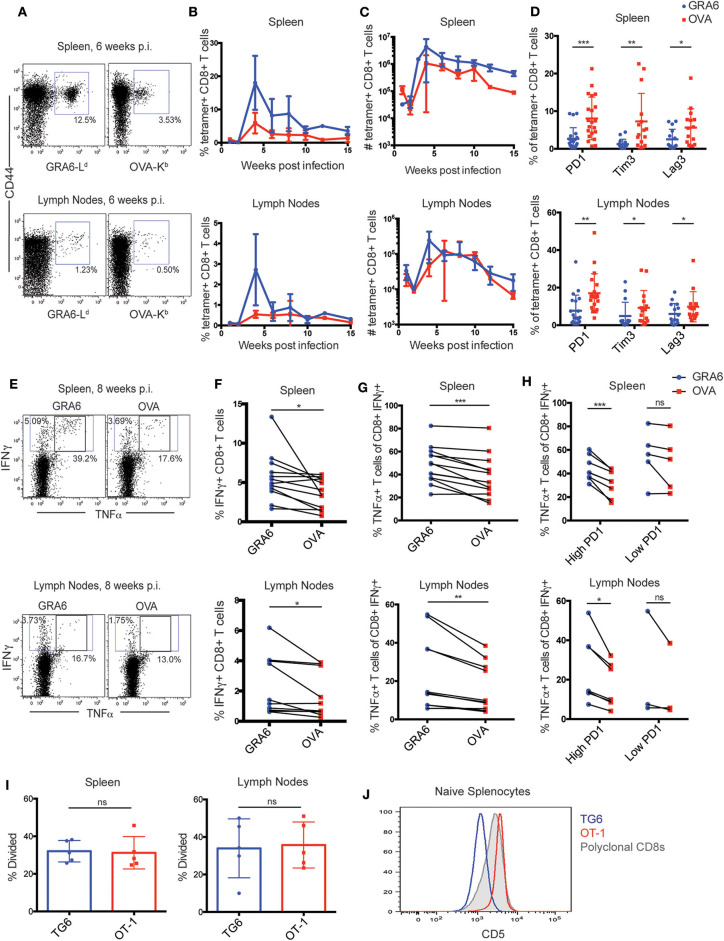
The OVA-Kb specific CD8+ T cell response to T. gondii infection shows signs of functional exhaustion. (A–H) H-2b/d mice were infected intra-peritoneally (i.p.) with 105
T. gondii Pru-OVA parasites and were sacrificed during the chronic infection (3–15 weeks). (A) Representative flow cytometry plots gated on live, singlet, CD8+ T cells and (B) compiled data showing percentage and (C) absolute numbers of GRA6-Ld (blue) and OVA-Kb (red) tetramer+ CD8+ T cells from the spleens and lymph nodes of infected mice. Graphs in (B,C) represent a total of 2–6 mice at each time point [n = 26 (spleen), n = 22 (lymph nodes)], and graphs display mean values with error bars depicting the SEM. (D) Expression of T cell exhaustion markers PD1, Tim3, and Lag3 on GRA6-Ld and OVA-Kb tetramer+ CD8+ T cells in the spleen and lymph nodes [n = 21 (PD1), n = 15 (Tim3/Lag3)]. (E–H) Production of IFNγ and TNFα cytokines by GRA6 or OVA specific T cells isolated from the spleens (n = 13) or lymph nodes (n = 10) of infected mice. Splenocytes or lymph node cells were stimulated ex vivo with the HF10 (GRA6) or SIINFEKL (OVA) peptides at 1 μM in culture for 3 h, and cells were analyzed for cytokine production by flow cytometry. (E) Representative flow cytometry plots of IFNγ and TNFα in CD8+ T cells from the spleen or lymph node. Compiled data showing the percentage of IFNγ+ cells among CD8+ T cells (F), or the percentage of TNFα producing cells among the IFNγ+ CD8+ T cells in the spleen and lymph nodes (G). (H) Data shown in (G) are separated based on PD1 expression in each mouse, with “high PD1” defined as >5% PD1+ in GRA6-Ld or OVA-Kb CD8+ T cells. Data points from the same animal are indicated by connecting lines. Graphs in (D) and (F–H) are the summary of >5 independent experiments, with data from all chronic time points (3–15 weeks) graphed together. (I) GRA6 and OVA antigen presentation in the spleens and lymph nodes of mice infected with T. gondii Pru-OVA. H-2b/d mice were infected i.p. with 105
T. gondii Pru-OVA parasites. At 6 weeks post infection, mice were injected i.v. with naïve CFSE-labeled splenocytes consisting of 106 TG6 and 106 OT-1 CD8+ T cells and analyzed by flow cytometry 2 days post T cell transfer. Transferred T cells were distinguished by a congenic marker together with Vβ2 (TG6) or Vβ5 (OT-1). Proliferation of TG6 and OT-1 CD8+ T cells was assessed by dilution of CFSE in the spleen and lymph nodes. Values are the percent proliferated cells out of the transferred T cell population. Graphs in (I) show data from one experiment (n = 5), representative of 5 independent experiments (see Supplementary Figure 3A). (J) CD5 expression on splenic CD8+ T cells from TG6 (blue) and OT-1 (red) TCR transgenic mice. CD5 expression on polyclonal CD8+ T cells is shown for comparison (gray). Histogram is representative of >5 independent experiments. Statistical significance was measured by a t-test in (D,I) and a paired t-test in (F–H) with data from the same mouse paired (*p < 0.05, **p < 0.01, and ***p < 0.001, ns is not significant).